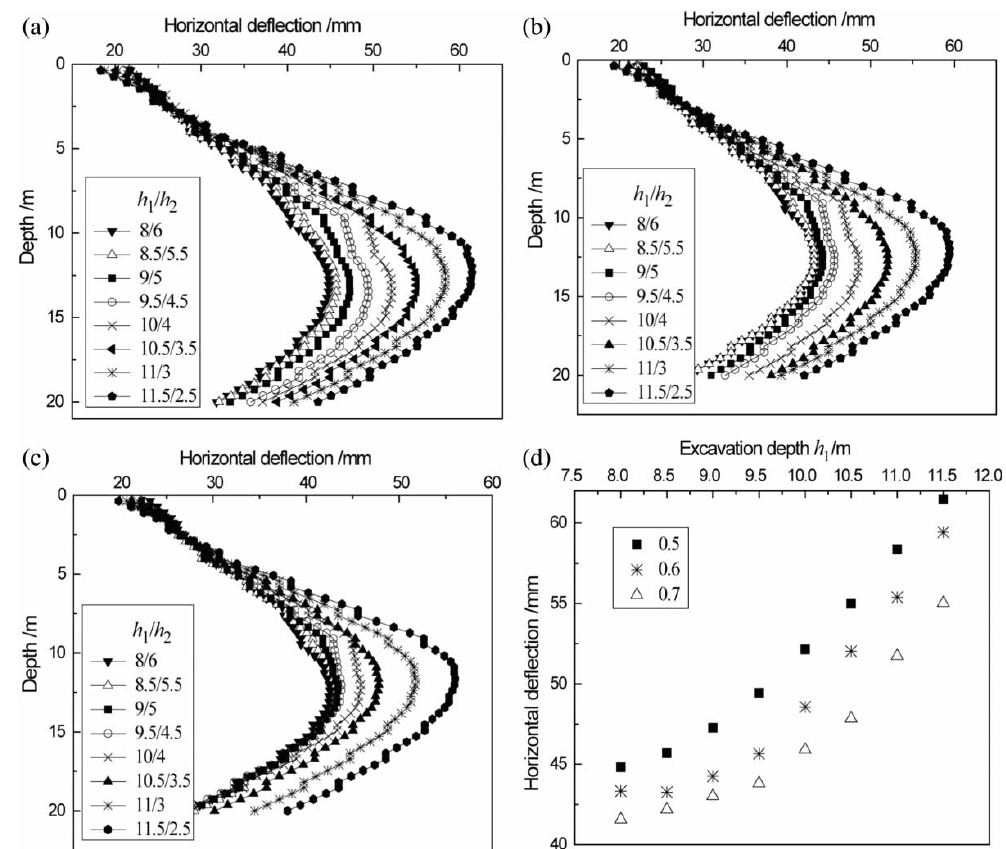
Fig. 9. Outer wall horizontal deflection at final excavation level for different embedment ratio of the inner support structure: (a) ratio of 0.5; (b) ratio of 0.6; (c) ratio of 0.7 (d) maximum deflection of outer wall for different embedding ratios of the inner support